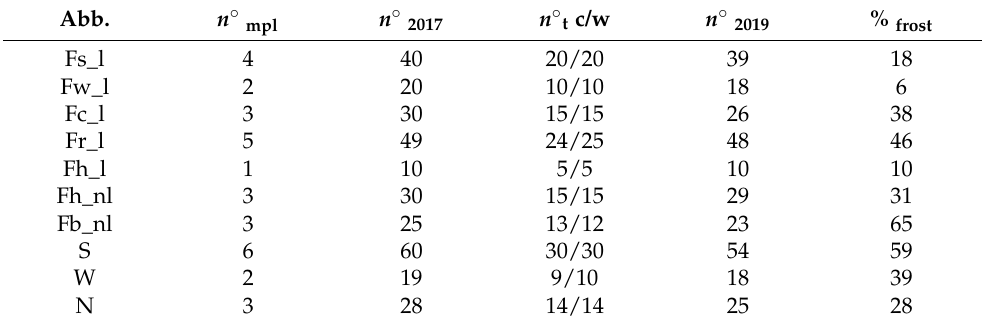
Table 2. Description of the beech seedlings in the common garden experiment. Abb.: abbreviation of